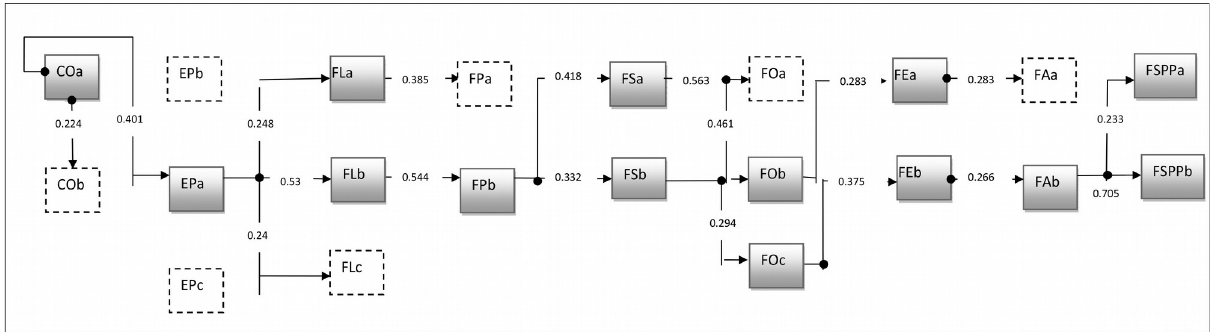
Figure 3. Relationship with factor of